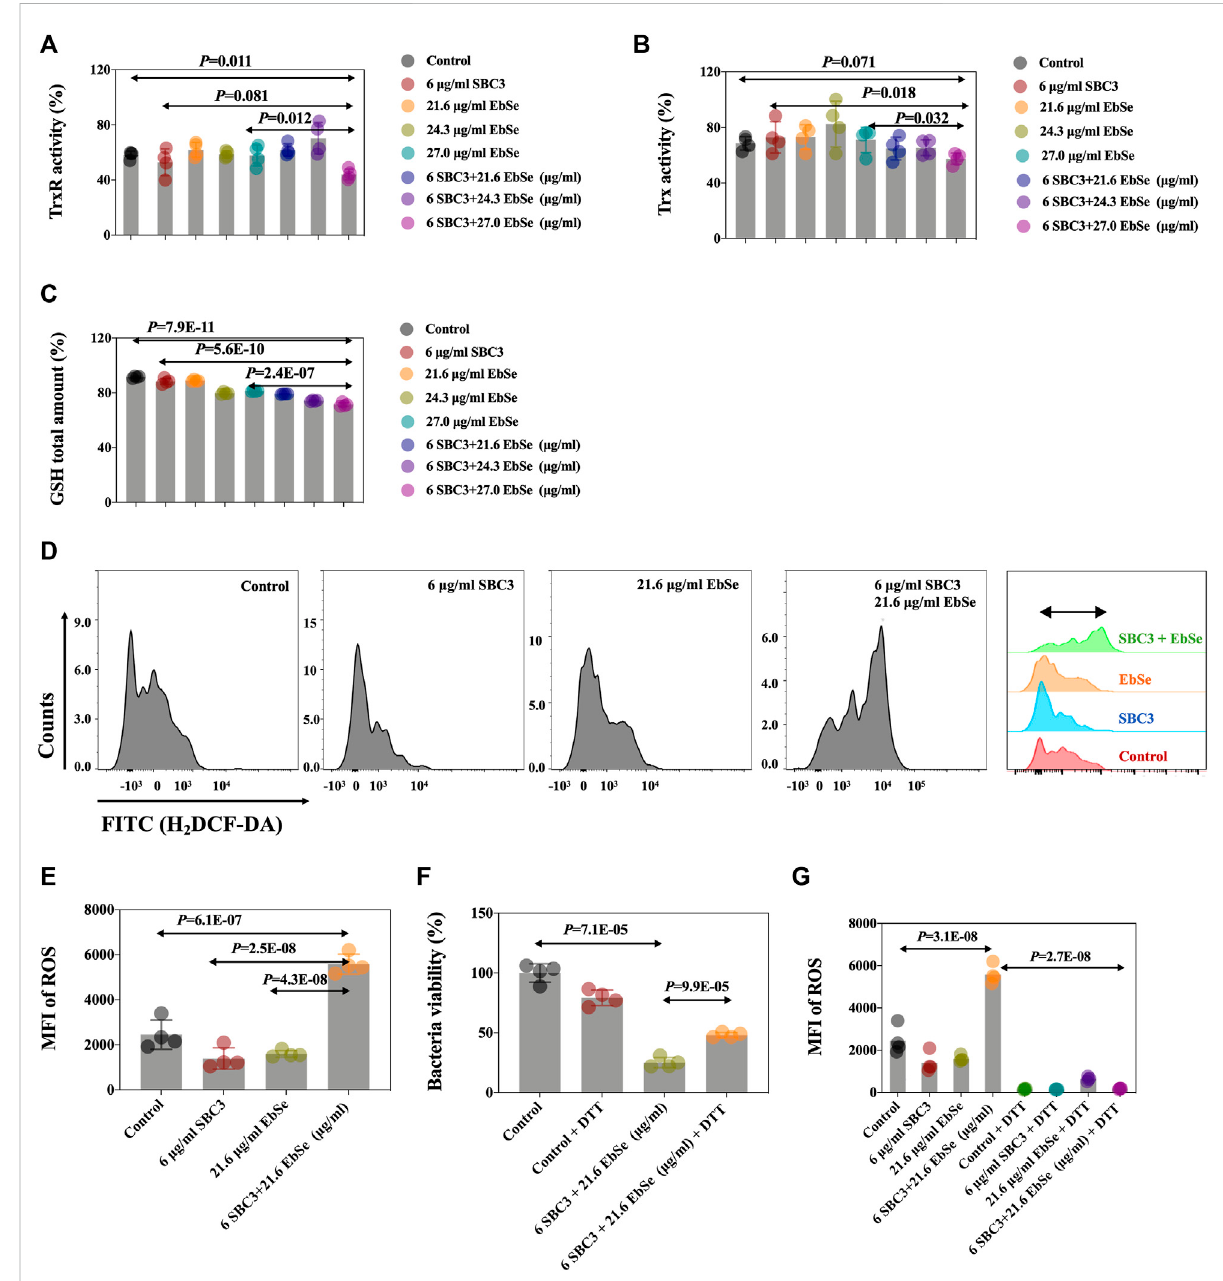
Antibacterial effect of Ebselen and SBC3 on DHB4 targeting TDRS system and producing of ROS. E. coli DHB4 was cultured until an A 600 = 0.4 and treated for 30 min with SBC3 and Ebselen. (A) TrxR activity endpoint was detected using DTNB reduction assay in the presence of Trx in DHB4extracts. (B) TrxactivityendpointwasdetectedusingDTNBreductionassayinthepresenceofTrxRinDHB4extracts. (C) GSHactivityendpoint wasdetected using DTNBreductionassay in thepresence ofGR inDHB4 extracts. (D,E) Mean fl uorescentintensity(MFI) ofH 2 DCF-DA-stained DHB4 was used to detect ROS level by fl ow cytometry. (F) UV-vis at A 600 has been used to present DTT could save E. coli DHB4 from SBC3 and Ebselentreatment. (G) FlowcytometryhasbeenusedtodetectDTTcouldstatisticallydown-regulatetheintracellularROSproductionlevelof E.coli DHB4. Data are presented by ONE-WAY ANOVA, p < 0.05 constitutes statistical signi fi